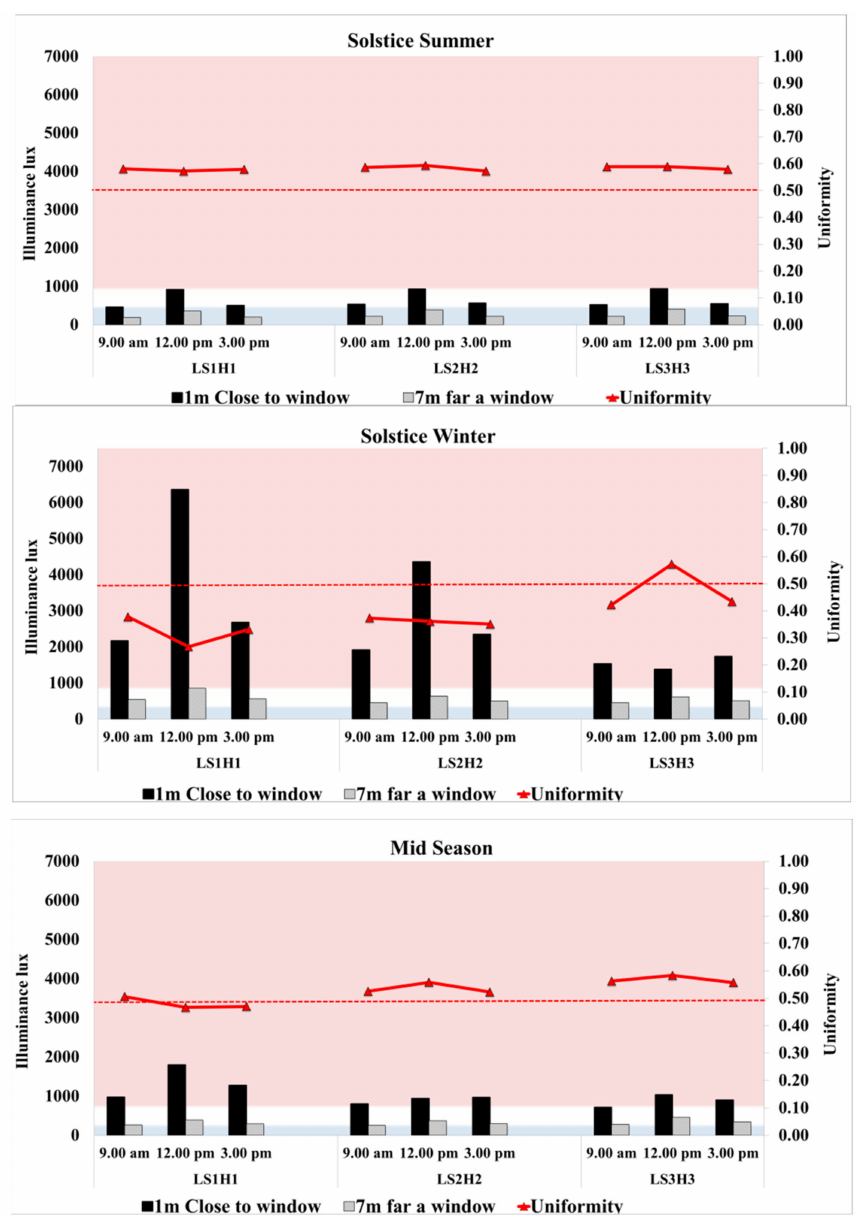
Figure 6. The e ff ect of the position of internal and external light shelves at a distance of 1 m and 7 m from the